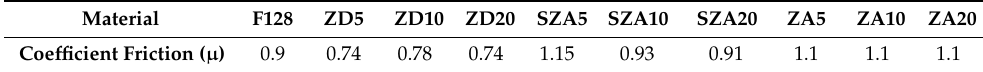
Table 7. Coefficient friction of the tested